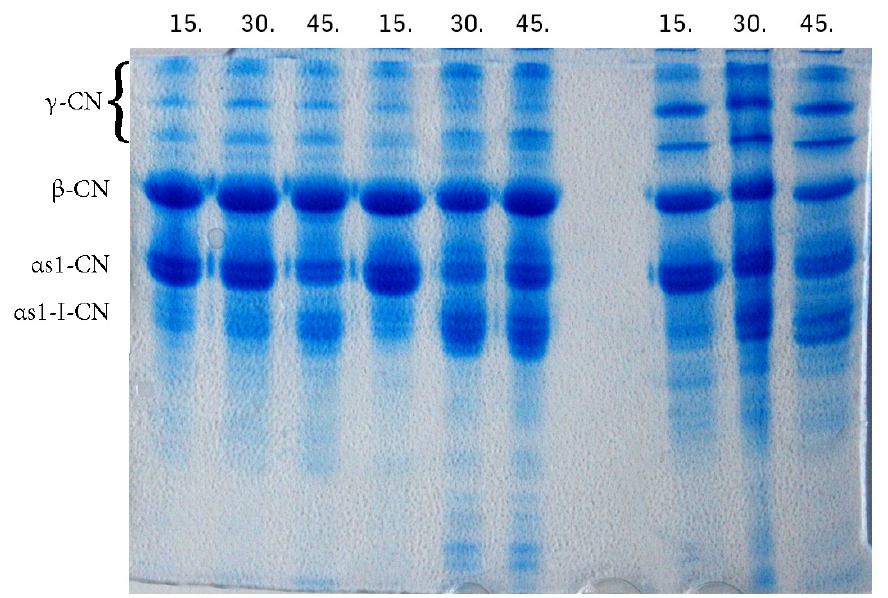
Figure 2. Urea–polyacrylamide gel electrophoresis patterns of Sir iz mišine at 15, 30 and 45 days of ripening. From right to left: Lactococcus lactis ssp. lactis S1; Lactobacillus plantarum B; mixed culture ( L. lactis S1 + L. plantarum B).